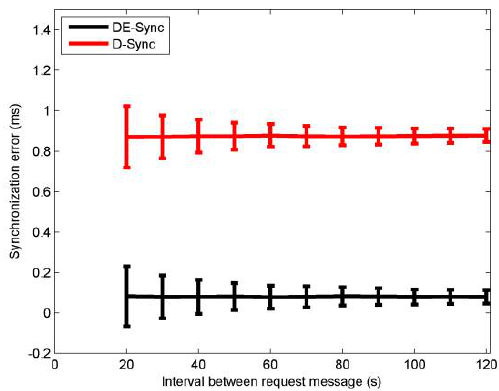
Figure 7. Effect of message interval.